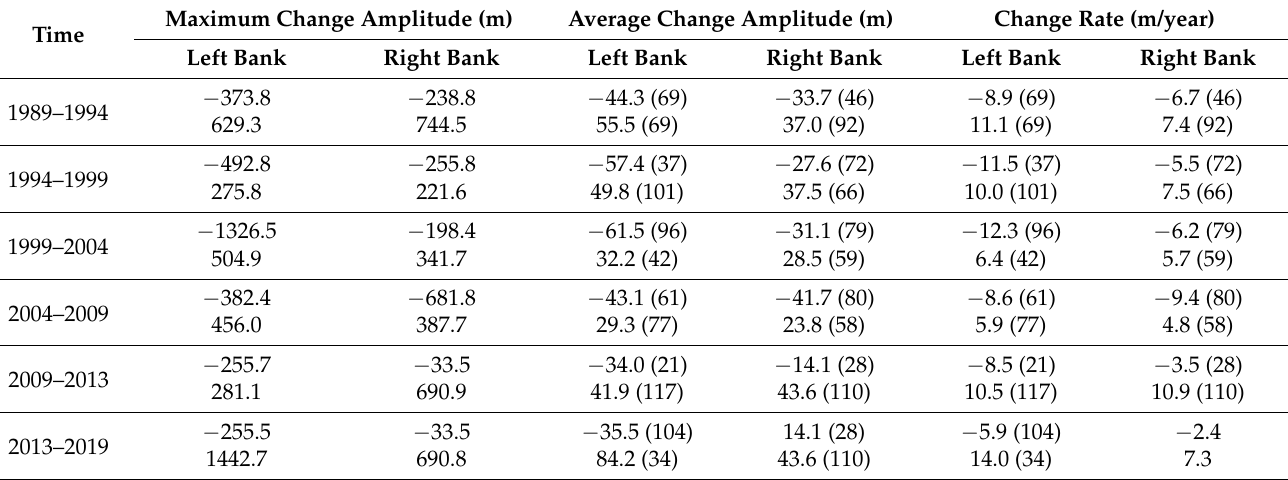
Table 4. Change rates of the left and right banks from 1989 to 2019.